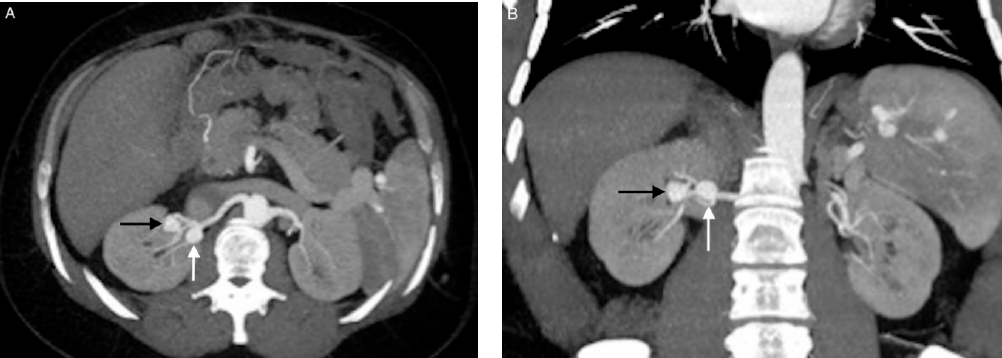
Figure 1. Images from patient 6. ( A ) and ( B ) Computed tomography angiography showing aneurysms 6 (white arrow) and 7 (black arrow) at the hilum of the right kidney. Aneurysm 6 is located at the initial trifurcation of the renal artery and has a wide neck. Aneurysm 7 is more distal, at a secondary bifurcation of the renal artery, and has a narrow neck.